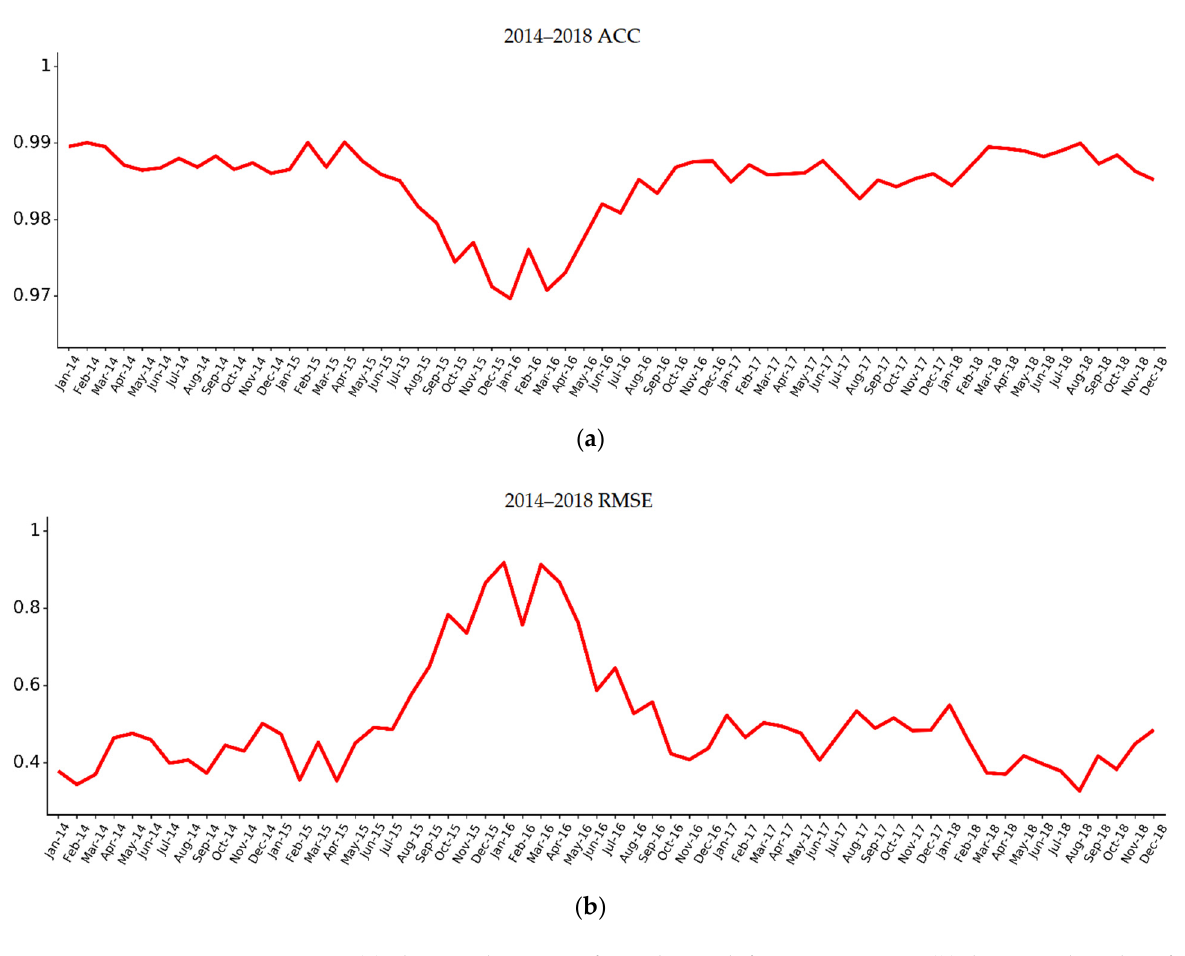
Figure 2. ( a ) The ACC histogram for each month from 2014 to 2018; ( b ) the RMSE line chart for each month from 2014 to 2018.